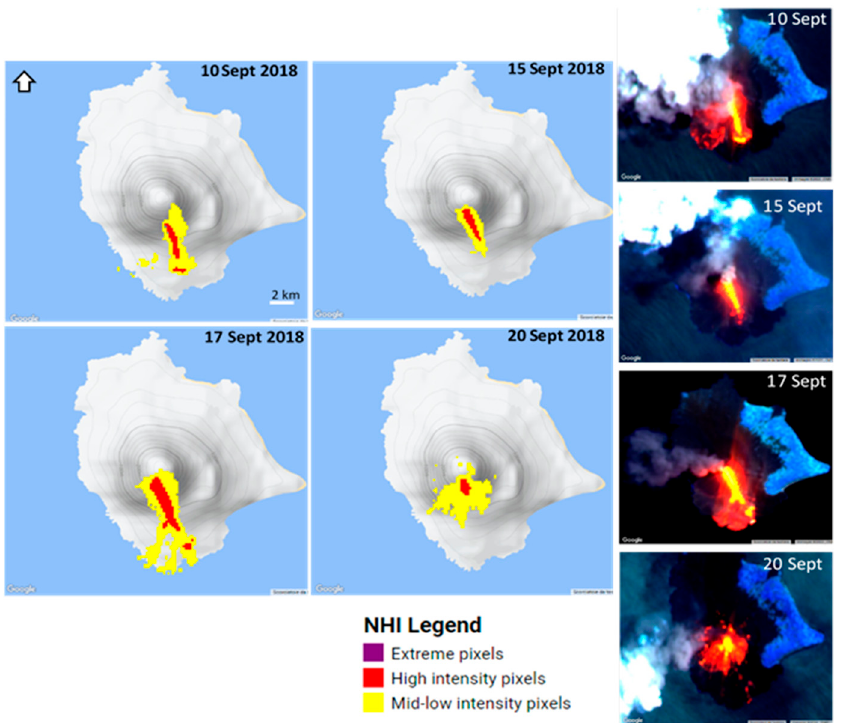
Figure 4. Lava flow maps of the Krakatau (Indonesia) volcano, from S2-MSI data of 10 September 2018 at 03:27 UTC, 15 September 2018 at 03:24 UTC, 17 September 2018 at 03:18 UTC and 20 September 2018 at 03:28 UTC, generated through the NHI tool. On the right, the RGB (Red = SWIR2; Green = SWIR1; Blue = NIR) images.